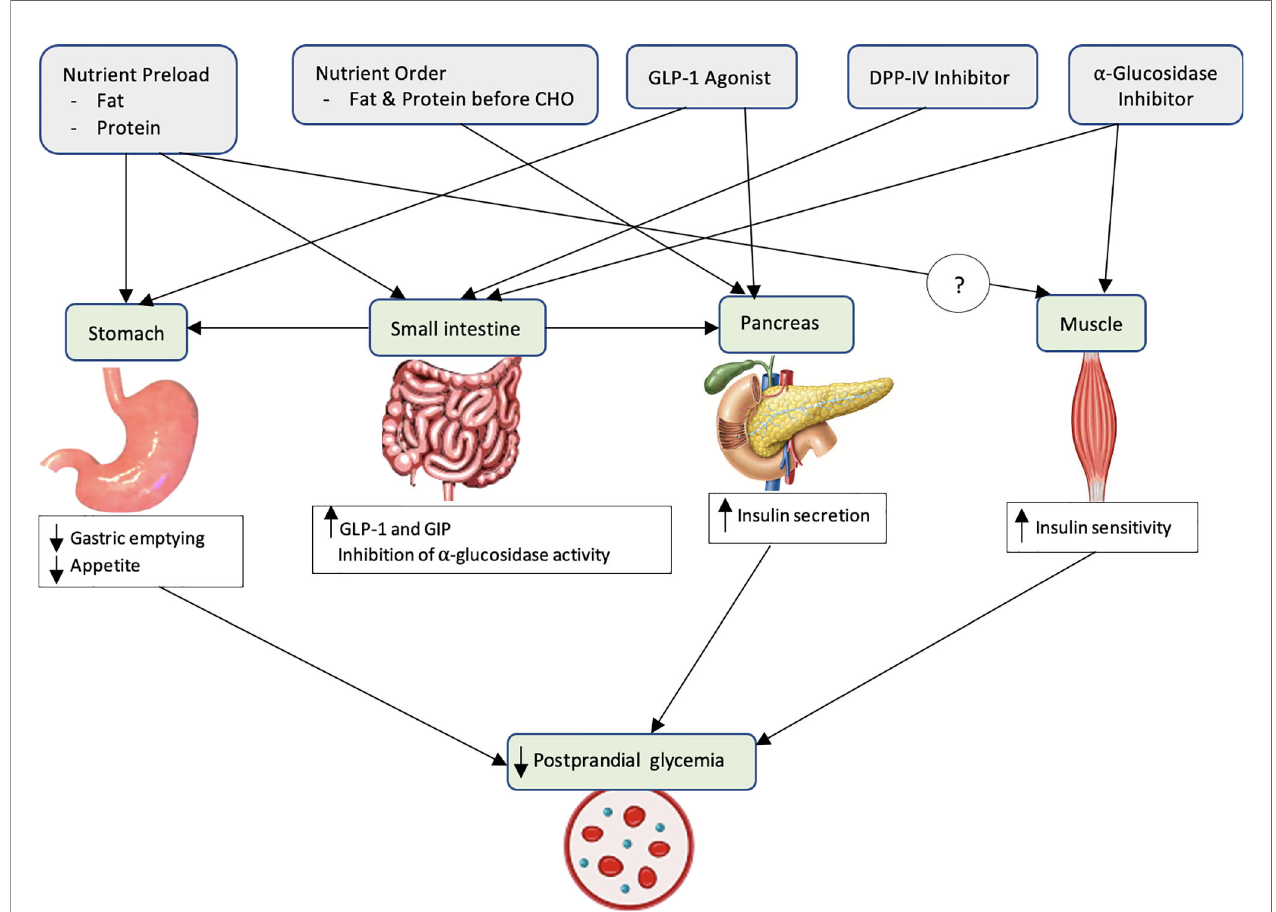
FIGURE 1 | Potential mechanisms of postprandial glucose lowering of various gut-based